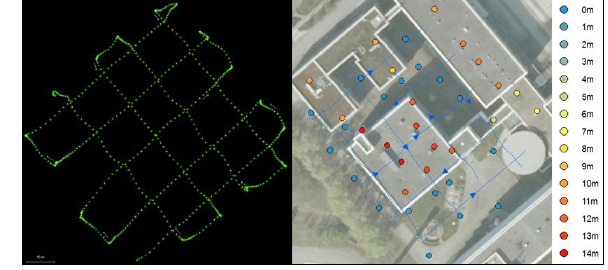
Figure 7: Post-processed trajectory of maiden flight (left) and GCP overview (right) with height above ground level scale